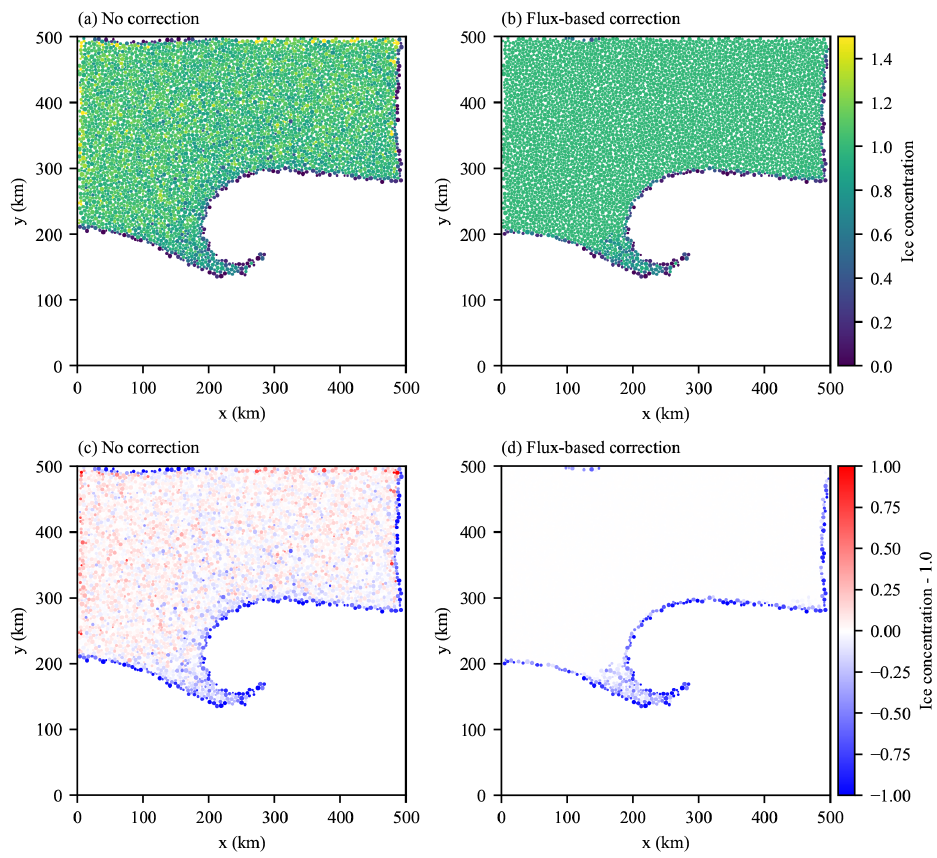
Figure 12. Vortex test case showing remapping without any correction (a, c) and with the flux-based correction (b, d) . (a, b) Ice concentration and (c, d) the difference from an ice concentration of